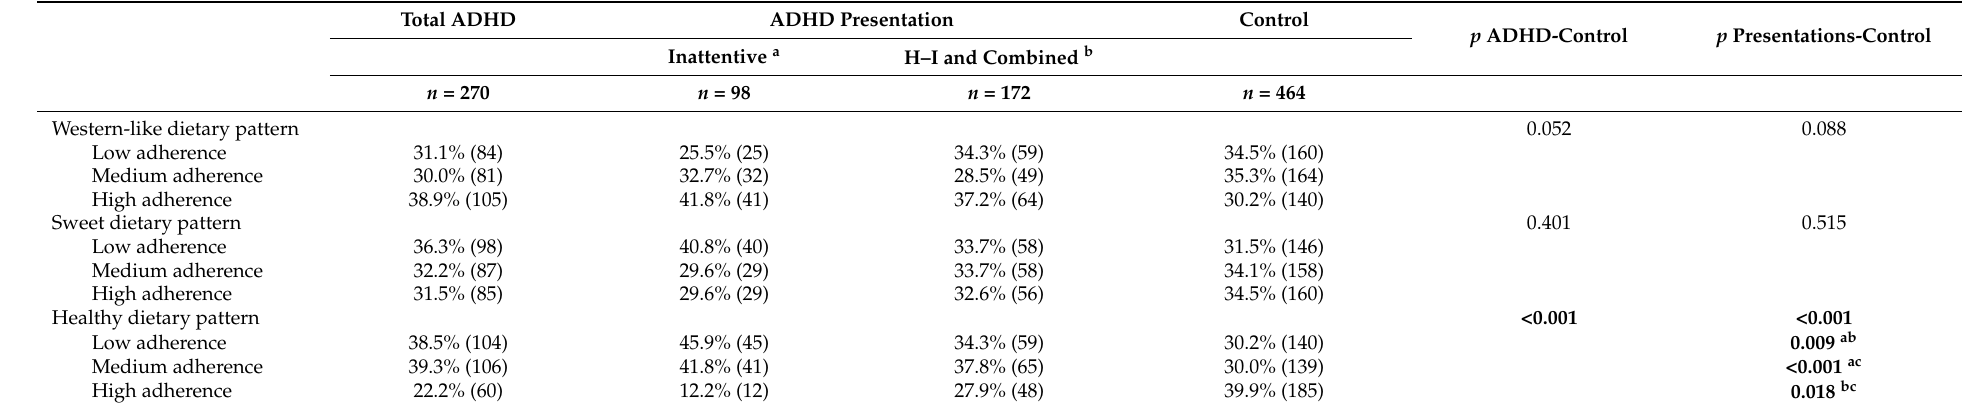
Table 4. Dietary pattern adherence per diagnosis and ADHD